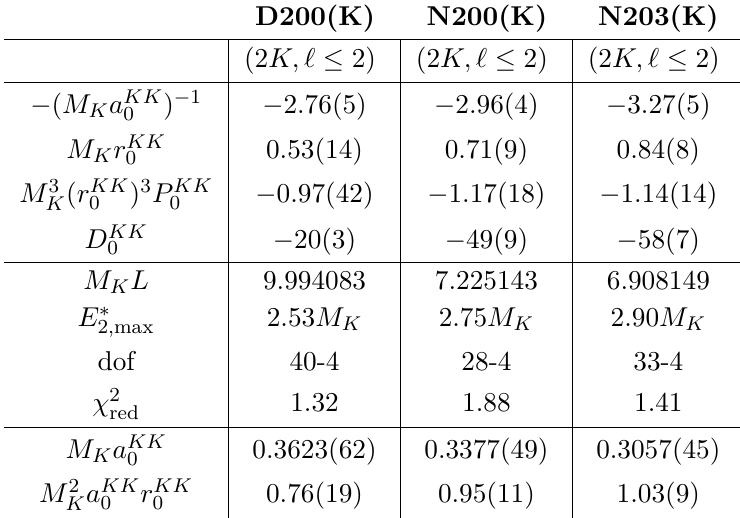
Table 13. Fit results for two kaons using the ERE form of the s -wave phase shift. We stress that here M K L is a fixed input to the quantization condition, chosen to be consistent with the lattice results in table